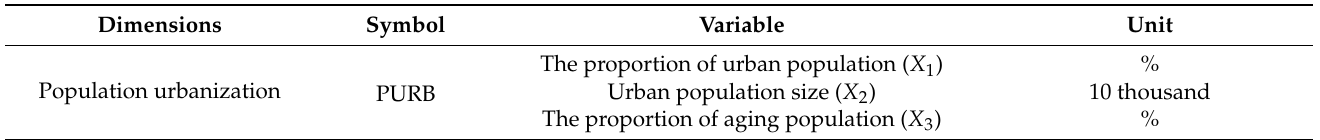
Table 1. Urbanization